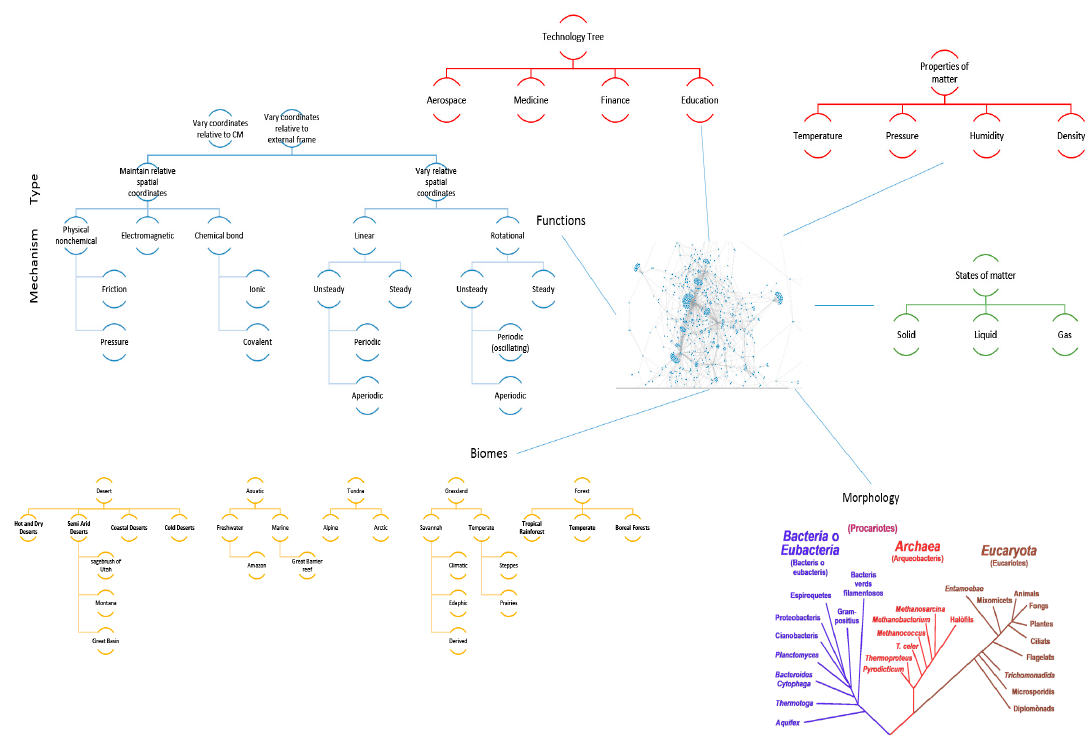
Figure 12. PeTaL ontology framework. Individual ontologies may be swapped.